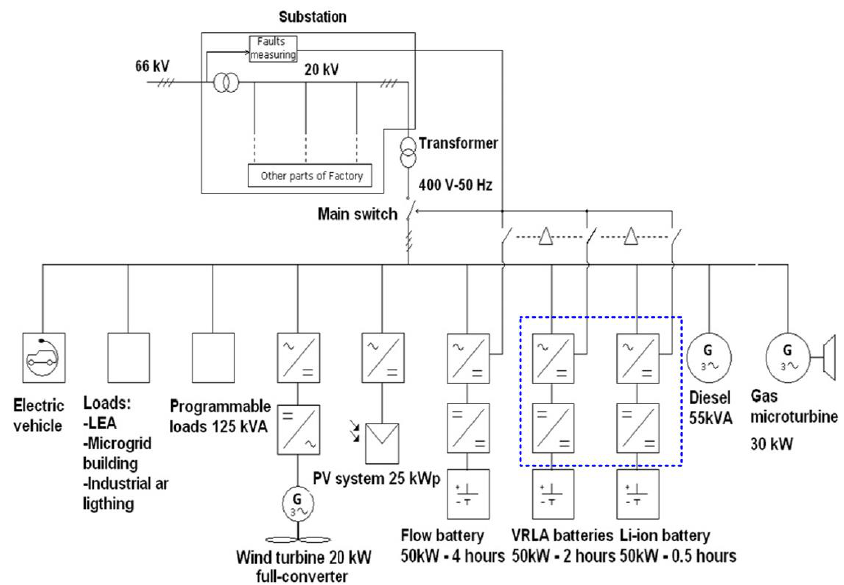
Figure 1. Diagram of the ATENEA microgrid at The National Renewable Energy Centre (CENER). A blue dashed box indicates the two possible direct current–alternating current (DC–AC) converters that can implement the proposed strategies.